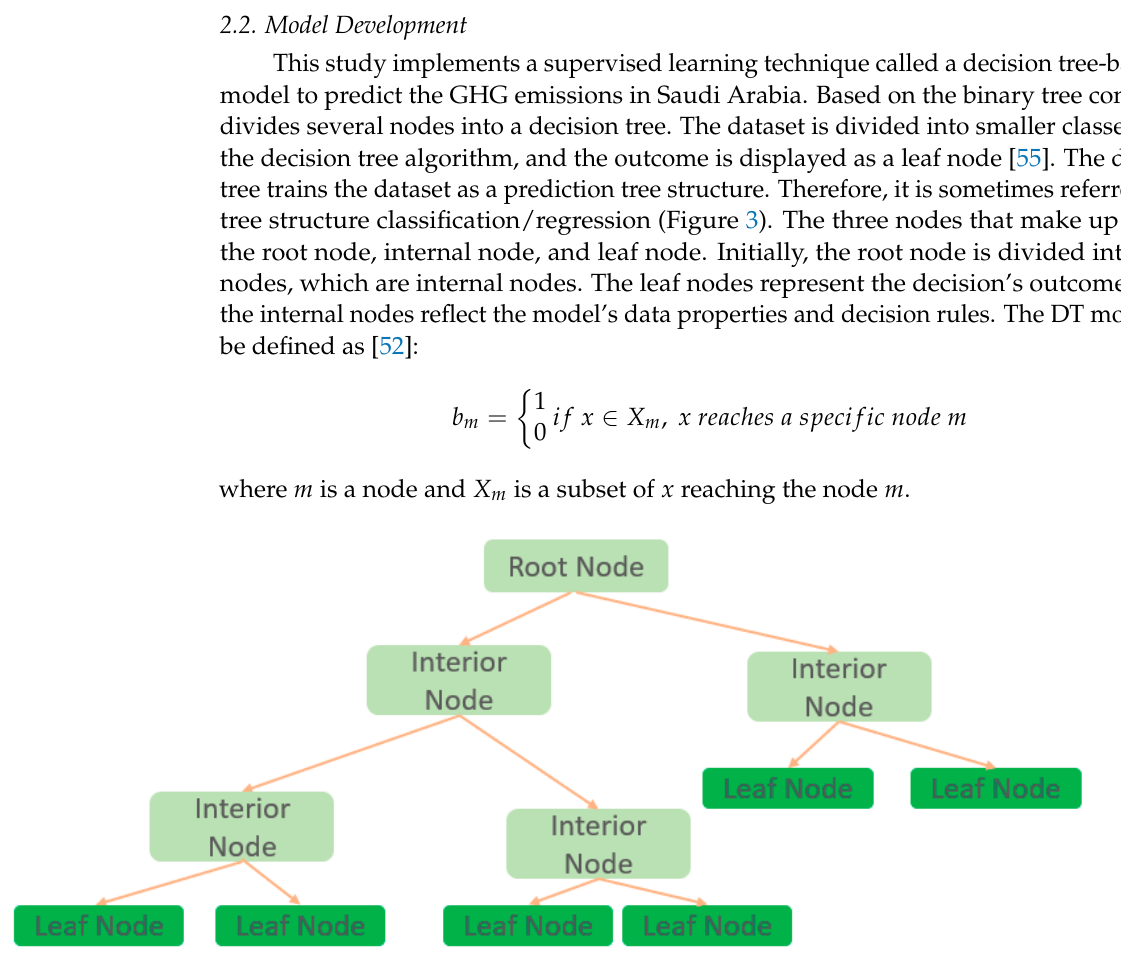
Figure 2. Correlation matrix plot of the dataset.